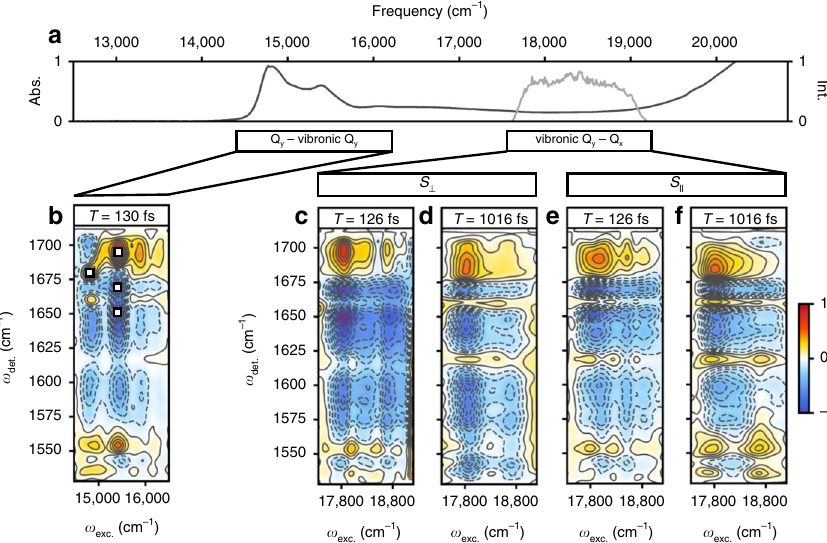
Fig. 1 Linear absorption and two-dimensional electronic – vibrational (2DEV) spectra of LHCII. a Linear absorption spectrum of LHCII at 77 K, along with the spectrum of the visible pump pulses employed in this work (light gray). b Representative 2DEV spectrum of the Q y bands of LHCII at T = 130 fs, prior to signi fi cant Chl b → Chl a transfer. Throughout, ground-state bleach (GSB) features are positive (red) features and excited-state absorption (ESA) features are negative (blue) features. Four regions have been marked in the spectra with white squares — one GSB in the predominately Chl a excitonic band (centered around 14,800 cm − 1 ) and one GSB and two ESA in the predominately Chl b excitonic band (centered around 15,500 cm − 1 ) . c , d Perpendicular polarization-associated (PA) 2DEV spectra of the vibronic Q y – Q x bands of LHCII at 77 K at waiting times of T = 126 fs and 1016 fs. e , f Parallel PA 2DEV spectra of the vibronic Q y – Q x bands of LHCII at 77 K at waiting times of T = 126 fs and 1016